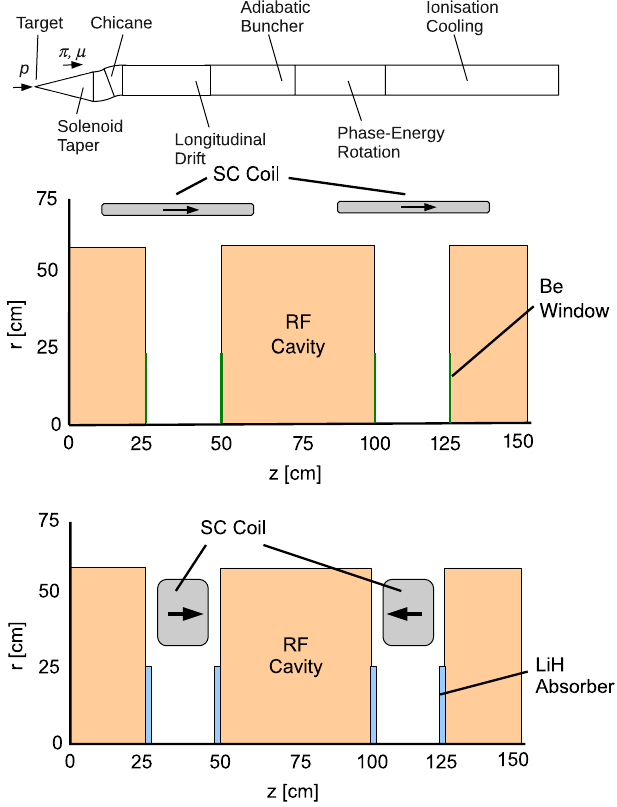
FIG. 3. (top) Schematic of the muon front end, (middle) rotator lattice, and (bottom) cooling